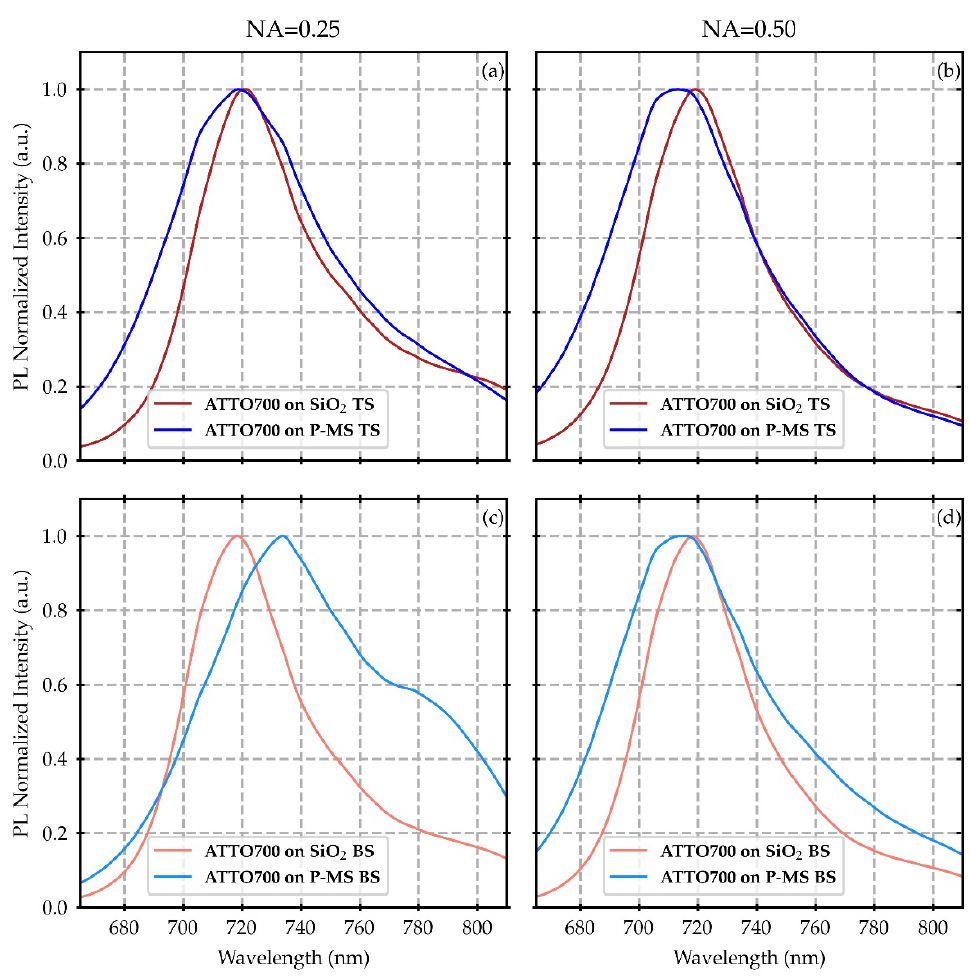
Figure 4. Normalized photoluminescence spectra of ATTO700 dye deposited on the top side of the plasmonic metasurface (P-MS) and the reference SiO 2 slide. The first row refers to the excitation and collection from the FS for microscope objective numerical apertures of NA = 0.25 ( a ) and NA = 0.50 ( b ). Panels ( c , d ) refer to the excitation and collection from the BS for microscope objective numerical apertures of NA = 0.25 and NA = 0.50, respectively.